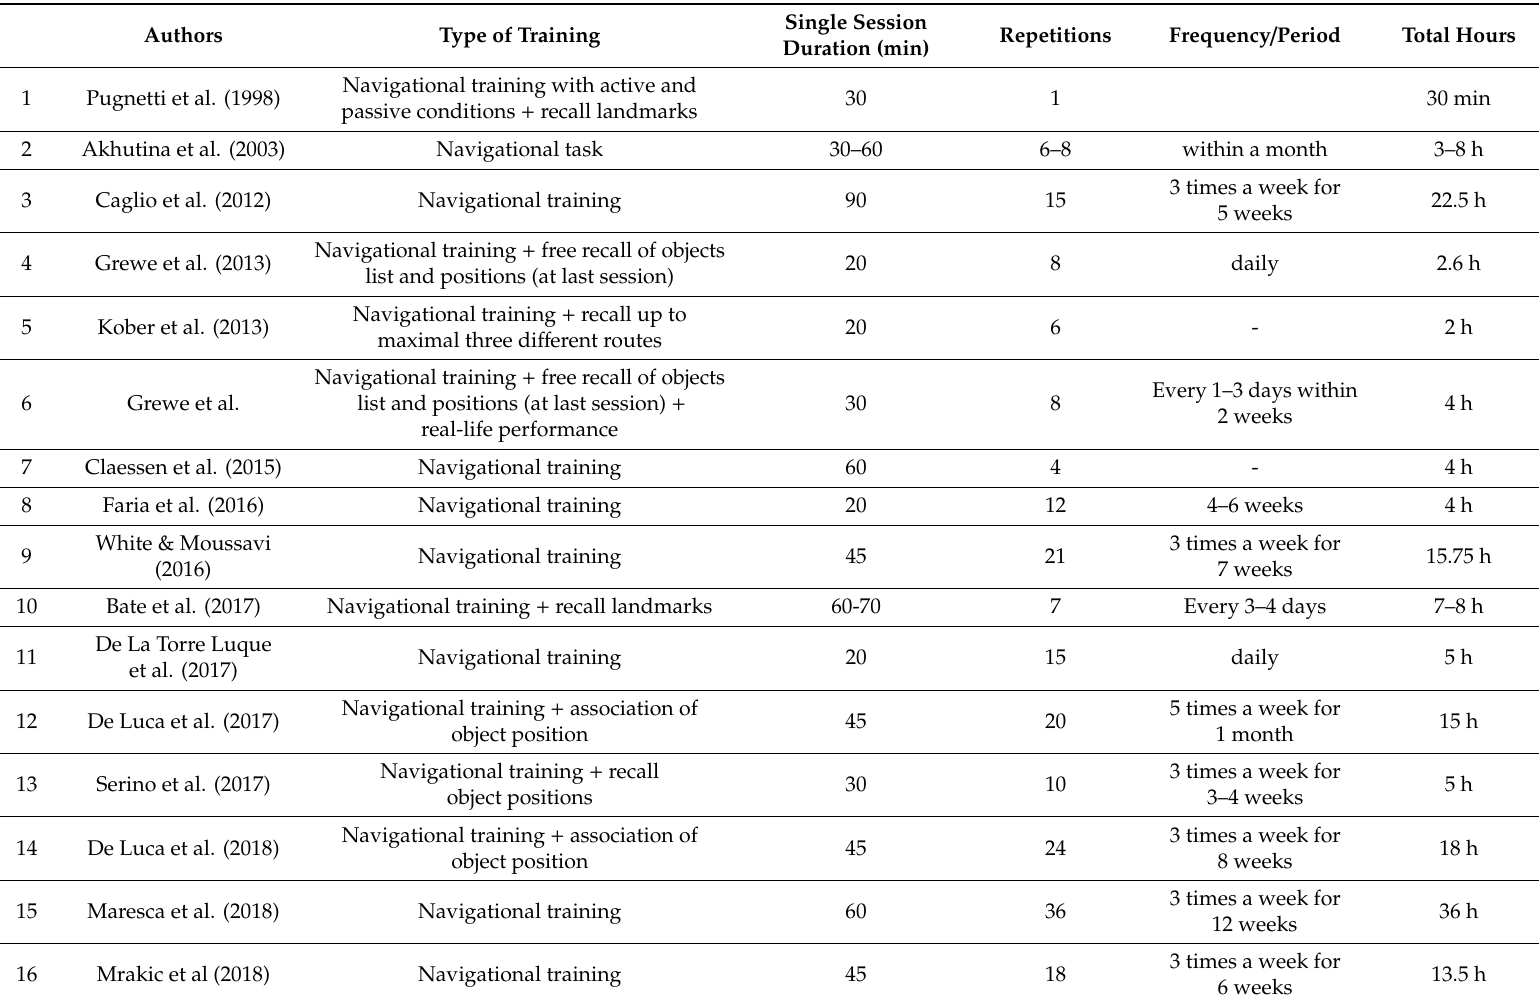
Table 2. Training